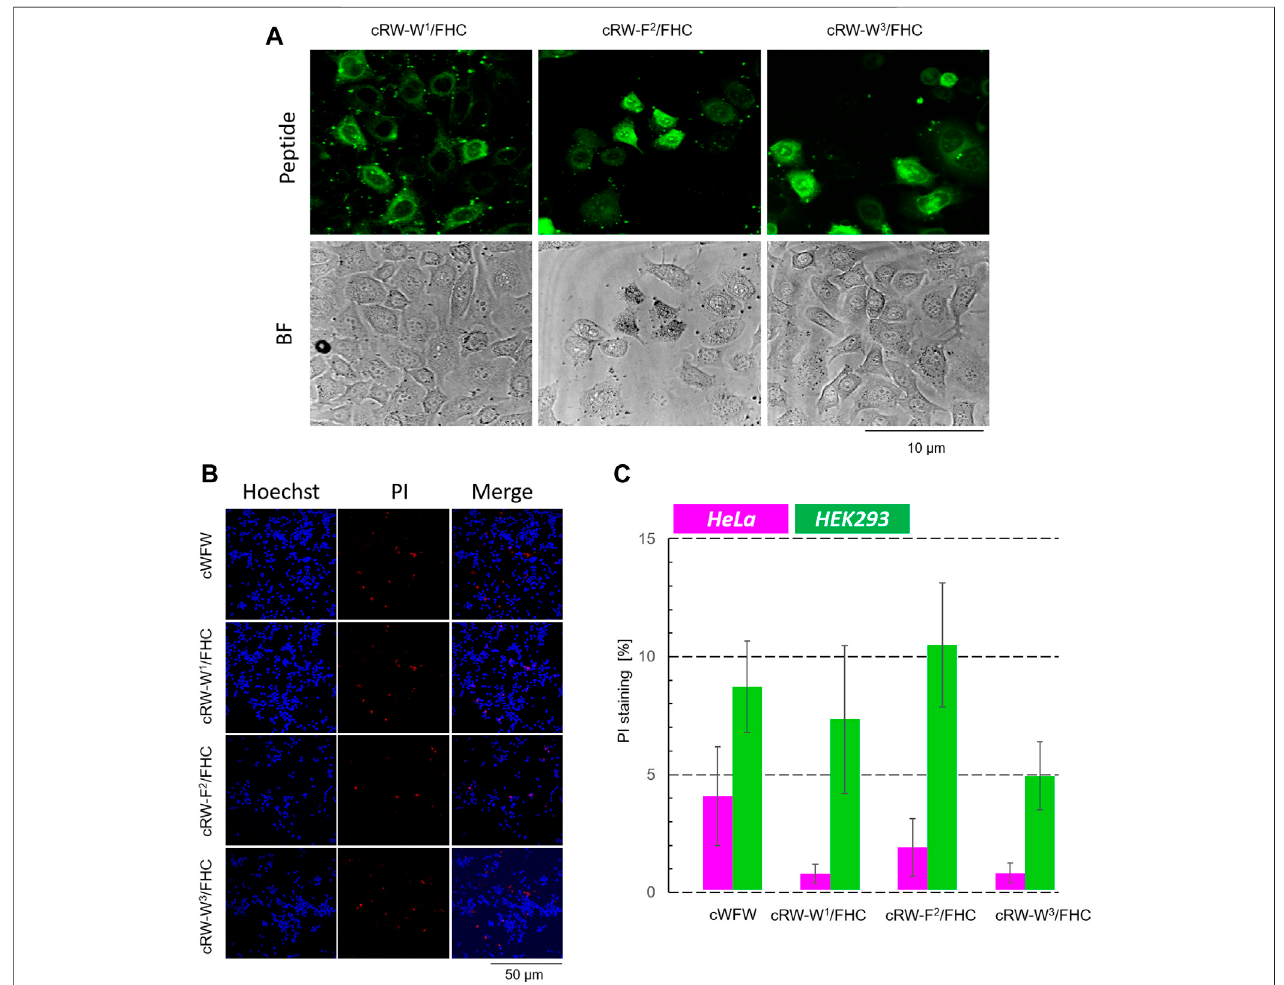
FIGURE 8 | Cytotoxicity evaluation of cWFW and its fl uorescent analogues by fl uorescence microscopy. (A) First, at higher magni fi cation (63 × objective), the cells were imaged to monitor cell entry of the peptides; HeLa cells with 20 µM peptide imaging after 1 h of incubation are shown for illustration. (B) After imaging (2.5 h after peptide addition), Hoechst/PI co-staining is applied and imaged at 20 × magni fi cation, exempli fi ed here by experiments with HEK293 cells; (C) Total/dead cell counting results for all peptides at 20 µM concentration co-incubated with both cell types.